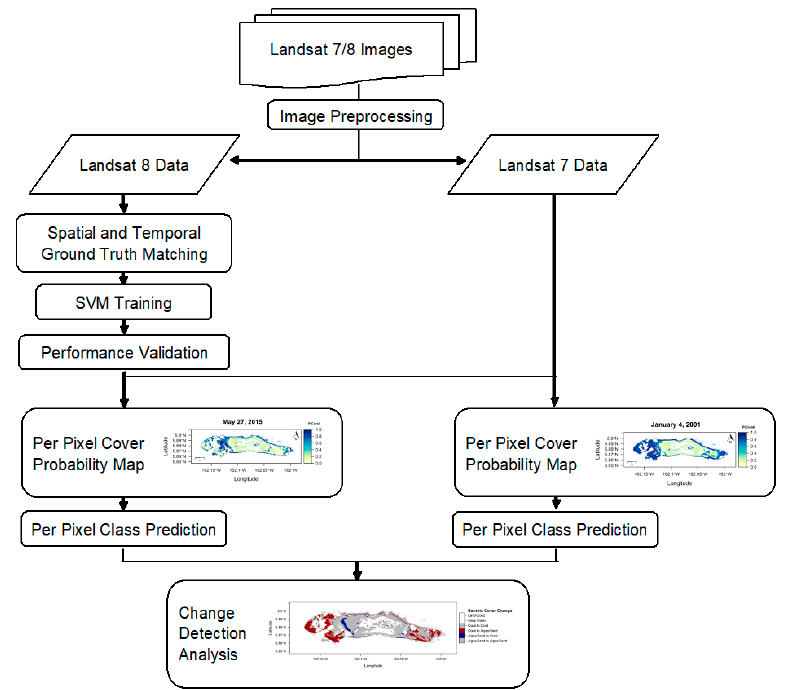
Figure 2. Support vector machine (SVM) classifier training and change analysis process flow for Palmyra Atoll, Kingman Reef, Baker Island Atoll, and Howland Island.